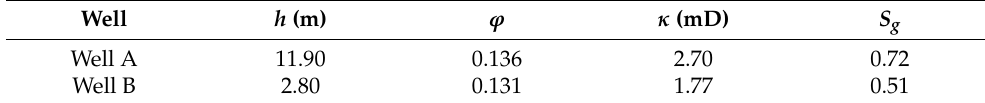
Table 2. Tight gas sandstone reservoir properties measured in two gas-producing